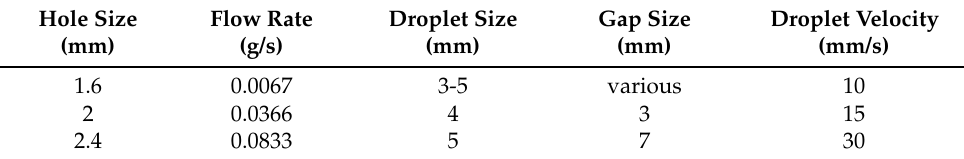
Figure 7. ( a ) Nearly uniform coating flow over a 2 mm diameter fishing line with a 2.4 mm hole; ( b , c ) non-uniformly spaced droplets on a 1 mm diameter fishing line with the diameter of the hole being 1.6 mm; ( d ) two sets of doublets on a 1 mm diameter fishing line with a hole diameter of 1.6 mm; ( e ) uniformly spaced four-droplet train on a 1 mm diameter fishing line with a hole diameter of 2 mm; ( f ) uniformly distributed train of four droplets on a 1 mm diameter fishing line with the hole diameter being 2.4 mm (the reference ruler on the left shows 1 mm tick marks, with 1/2 mm ones at the very top). Table 1. Experimental